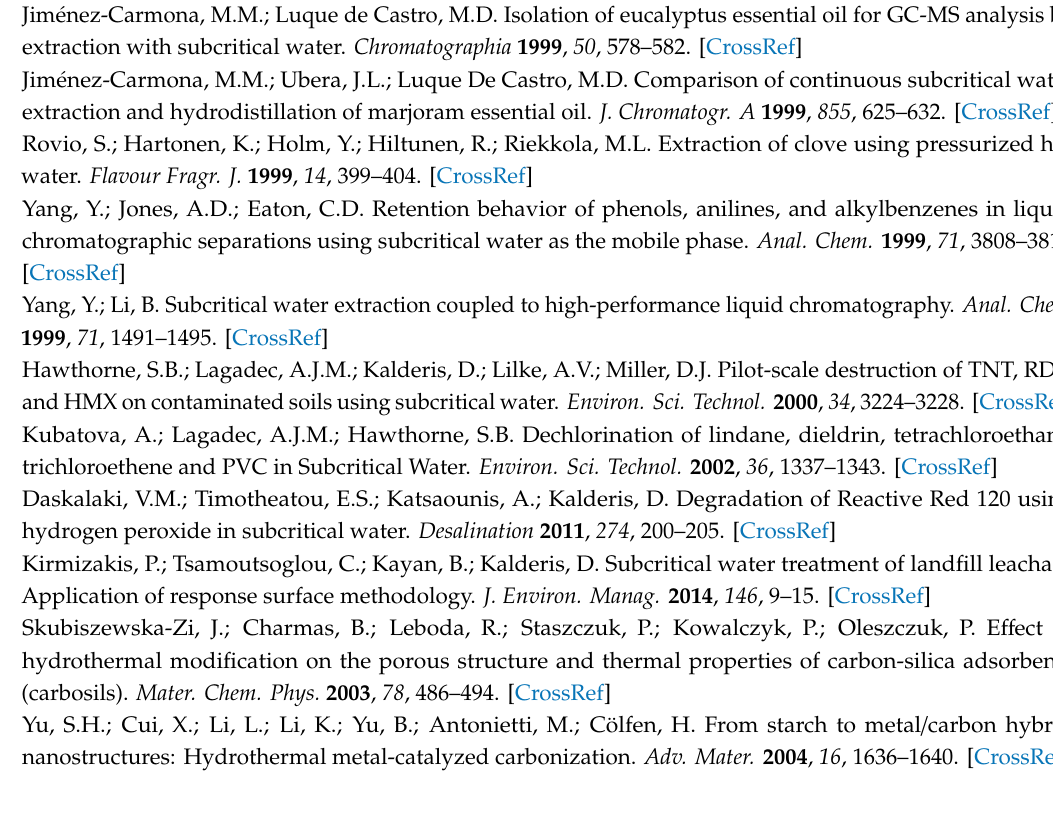
Figure S1: Architecture of a feedforward MLP ANN with one input, one hidden and one output layer., Figure S2: MRE (%) as a function of the number of neurons in the hidden